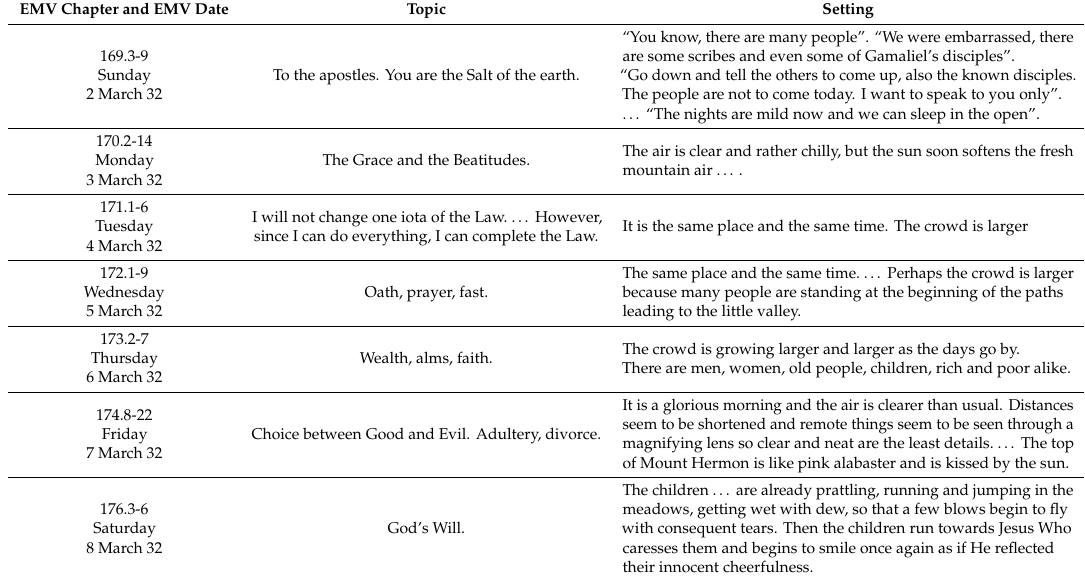
Table 4. Date, topic and setting of the speeches delivered at the Horns of Hattin (7 episodes). The dates have been estimated by the second